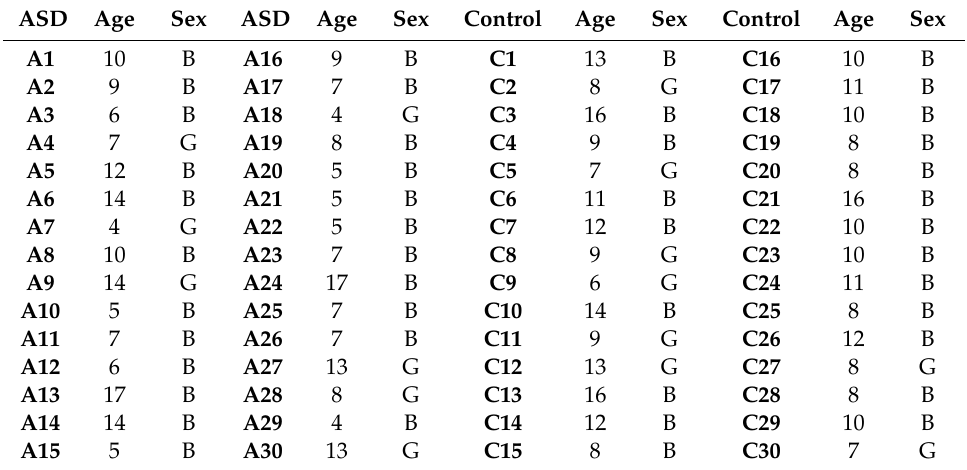
Table 1. Age and gender distribution in the samples, according to group (ASD or control) a